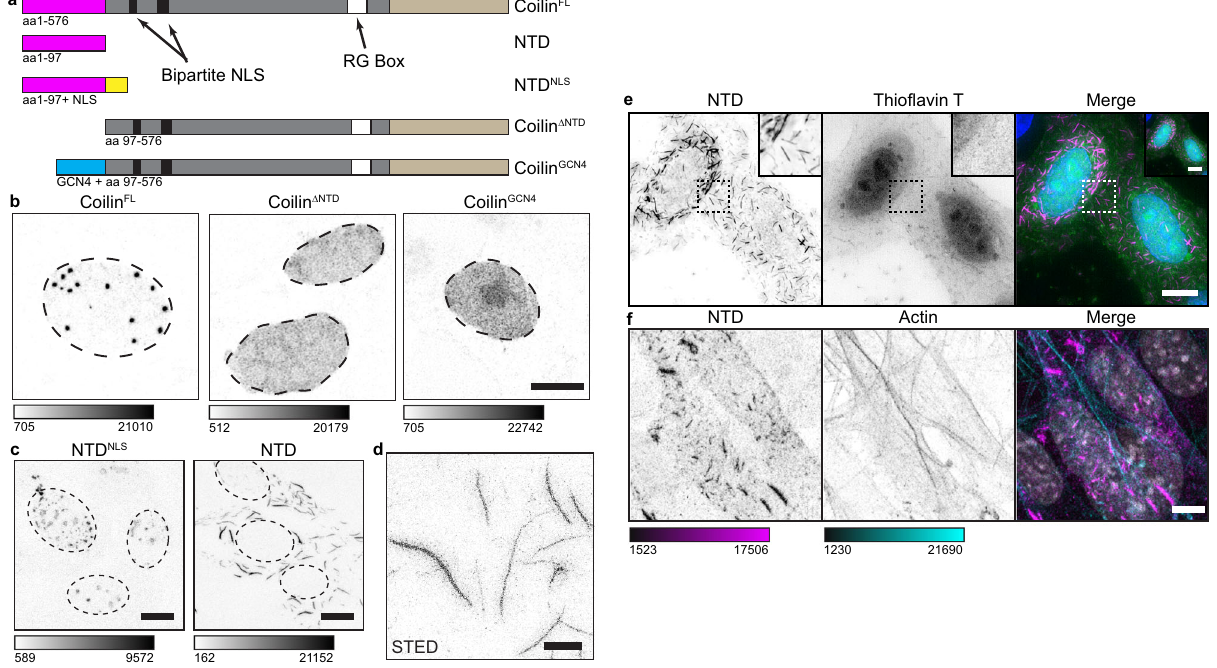
c Grayscale images NTD and NTD NLS transiently expressed in Coil − / − MEFs. d STED image of coilin NTD transfected Coil − / − MEFs. Scalebar= 2 µ m. e Cytoplasmic NTD- myc fi brils (magenta) in HeLa cells do not stain with Thio fl avin T (green). DNA visualizedwith Hoechst (blue). f Coil − / − MEFs transfectedwith NTD-myc (magenta) and counterstained with α -actin (cyan) to compare actin fi laments with cyto- plasmiccoilinNTD fi brils.DNAvisualizedwithHoechst(gray).Thisexperimentwas repeated independently two times with similar results. All imaged with Leica SP8 laser scanning confocal microscope. Color bars are in analog-digital units to indi- cate differences in expression. Dotted lines in b , c indicate the nuclear limits. Scalebars (all except d )=10 µ m; insets, 2 µ